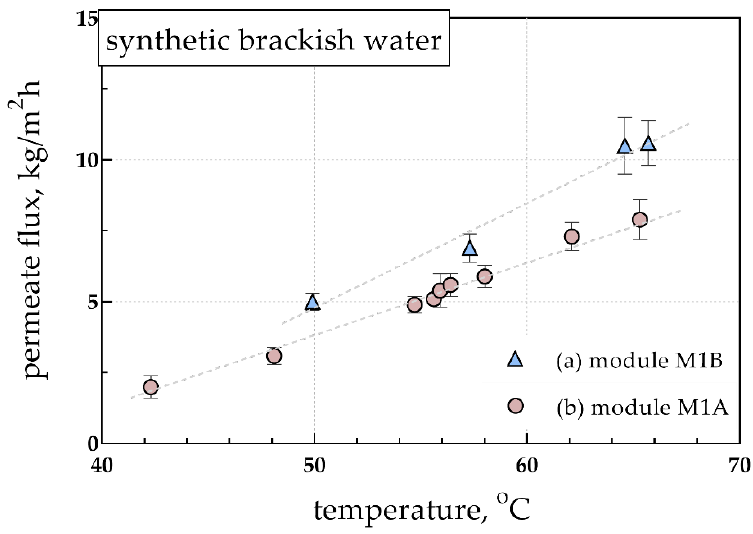
Figure 5. Permeate flux versus the feed solution temperature for the desalination of synthetic brackish water. Effective membrane area ( a ) module M1B, 0.067 m 2 , and ( b ) module M1A, 0.087 m 2 .